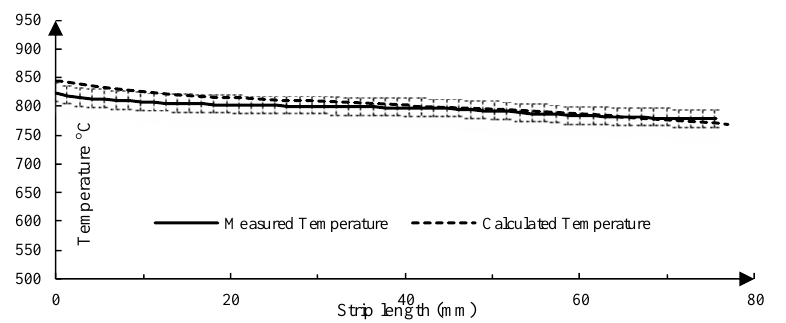
Figure 9. Comparison between the model and measured values in the longitudinal direction, line II–II in Figure 7b. Gas inlet position: surface A in Figure 2, Q = 2.66 Nm 3 /h, Strip velocity = v Strip (< 0.17 m/s) .